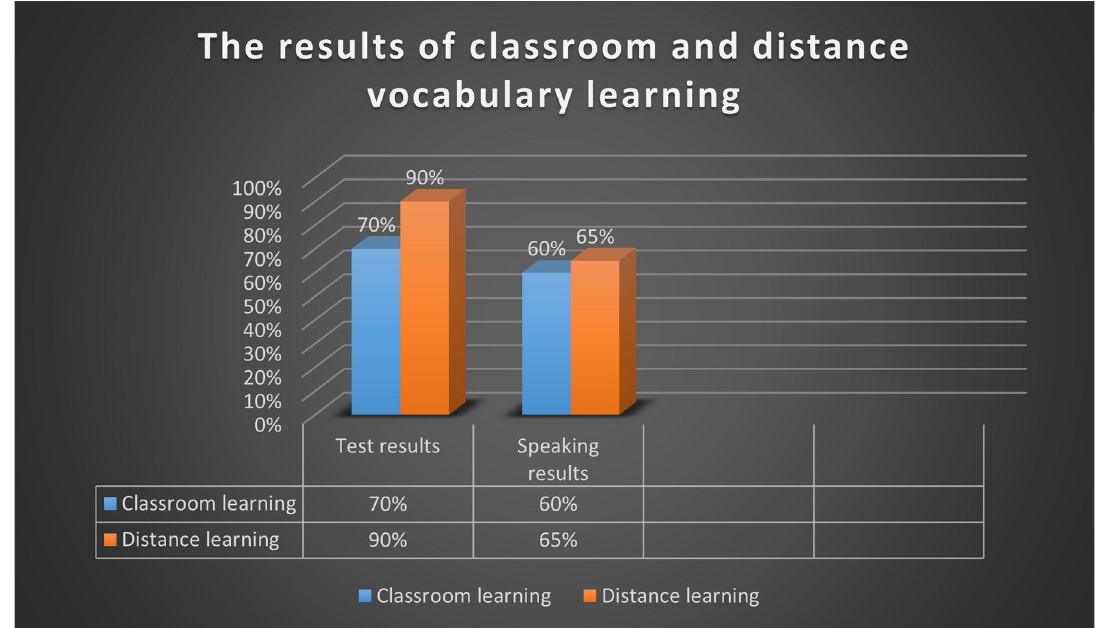
Figure 3 - The results of the level of topic-related vocabulary knowledge